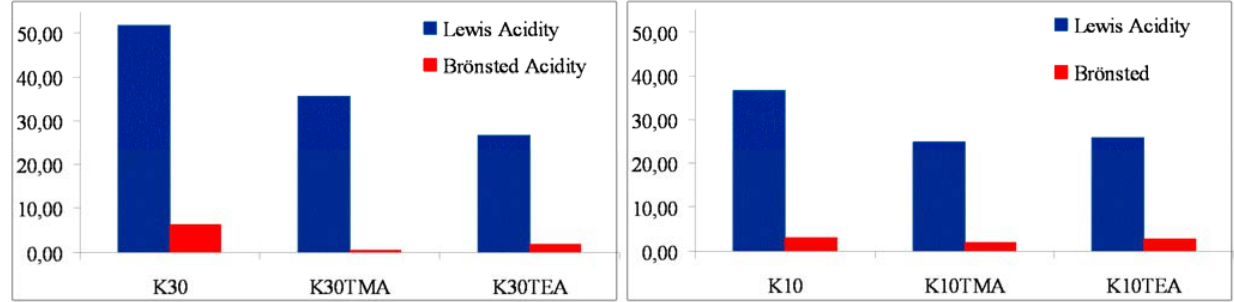
Figure 6. Evaluation of acidity from the IR/FT spectra of samples after pyridine sorption and degassed at 200